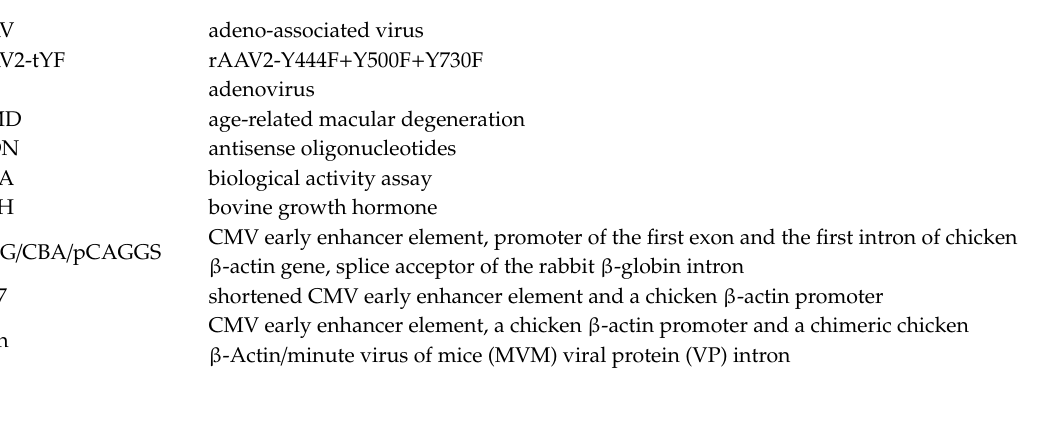
Description of clinical trial rAAV gene therapy products